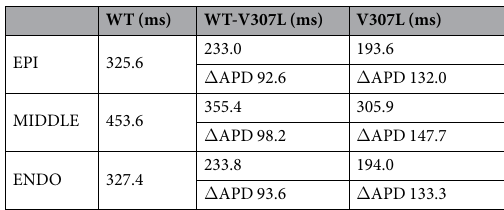
Table 1. Action potential duration in WT, WT-V307L and V307L conditions. Action potential duration (APD) was measured in all transmural cell types; epicardial (EPI), mid-myocardial (MIDDLE), and endocardial (ENDO) at a frequency of 1 Hz. Δ APD is measured relative to